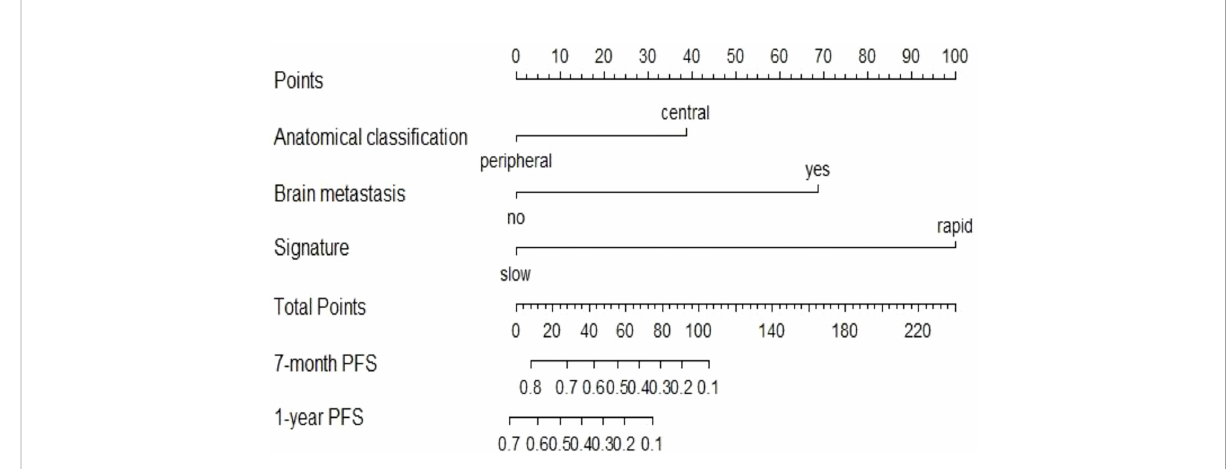
Anatomical classi fi cation (Central vs. Peripheral) Brain metastasis (Yes vs. No) Signature (Rapid progression vs. Slow progression) HR, hazard ratio; CI, con fi dence